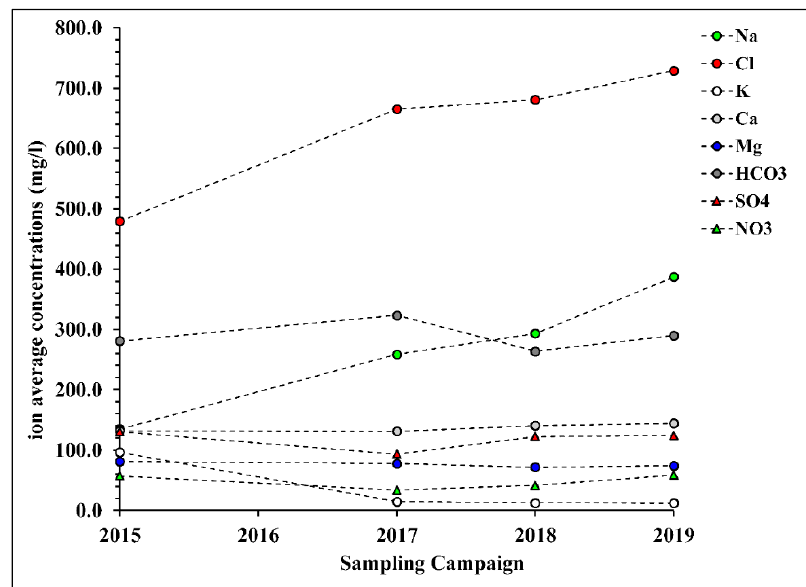
Figure 10. Variation of the chemical composition of groundwater in the Essaouira basin during the last five years.